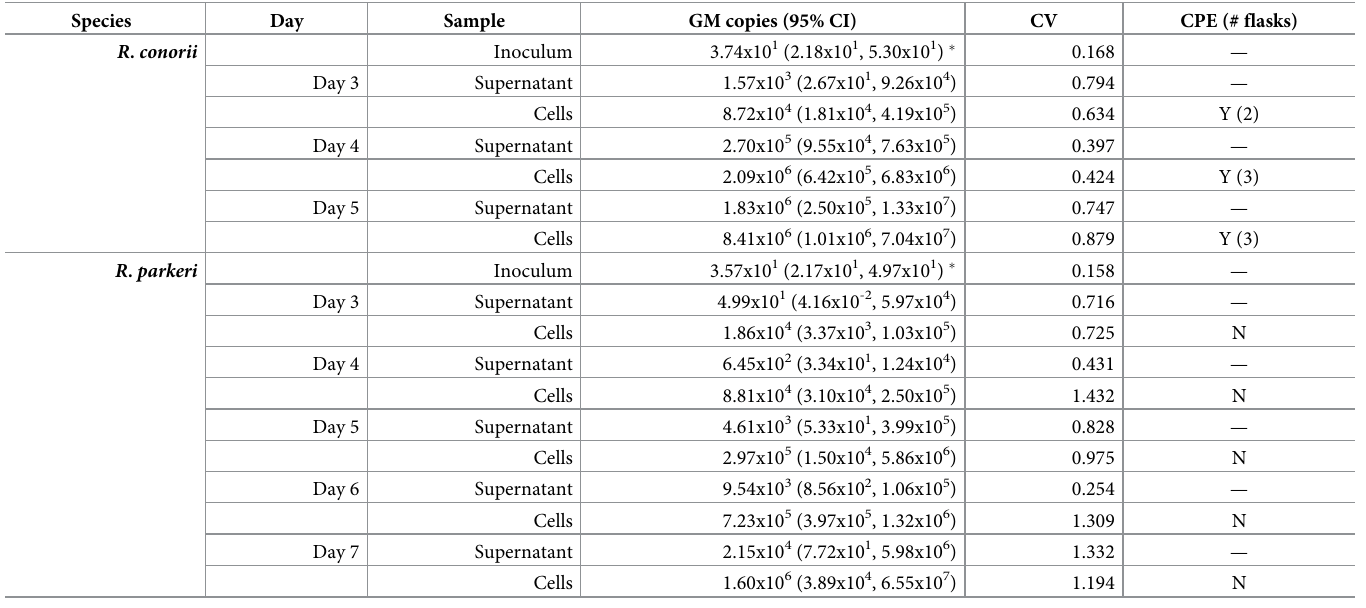
Table 2. Endpoint method comparison of average total copy number in supernatant accumulation and cellular amplification time course between SFGR strains.